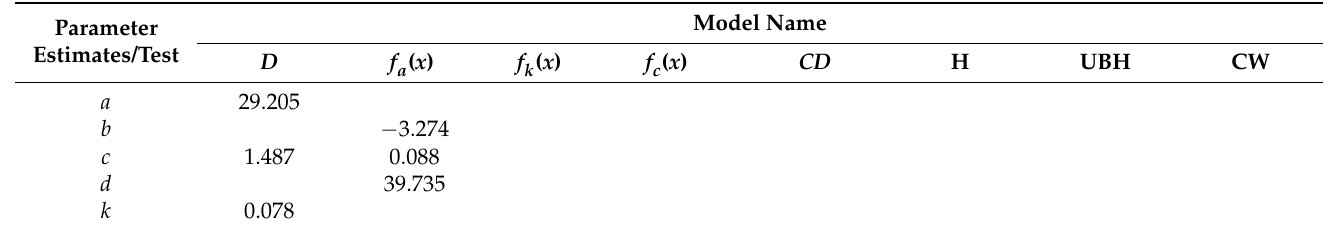
Table 6. Estimation and testing of parameters of Chinese fi r morphological structure growth model. Parameter Estimates/Test